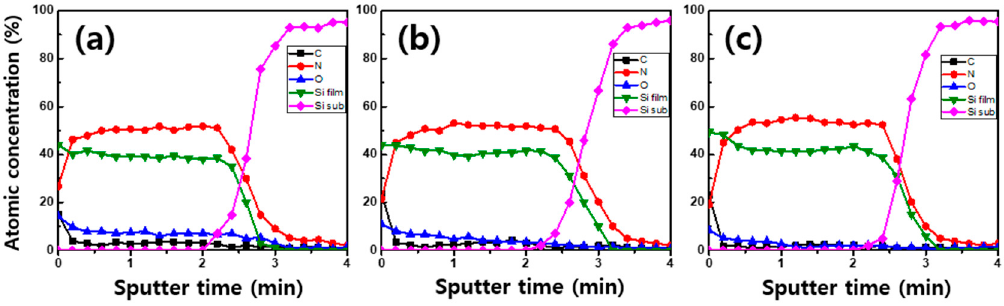
Figure 4. Auger electron spectroscopy (AES) depth profiles of RPALD SiN x film deposited at ( a ) 250 °C, ( b ) 350 °C, and ( c ) 500 °C.